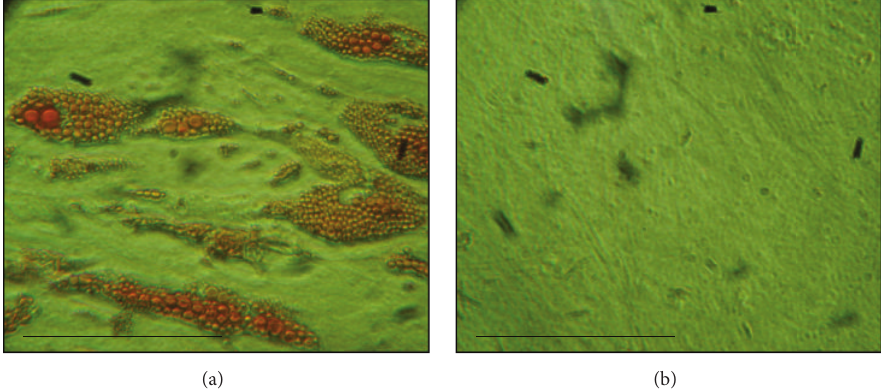
Figure 4: Adipose differentiated cells after 14 days in induction medium: sample after thawing of cryopreserved cells, phase contrast microscopy, 250x. (a) Presence of fat droplets (stained with Oil Red) in ADMSC cultivated with adipogenic induction medium. (b) Control does not have fat droplets, indicating the undifferentiated cells cultivated with standard medium. Scale (10 𝜇 m).